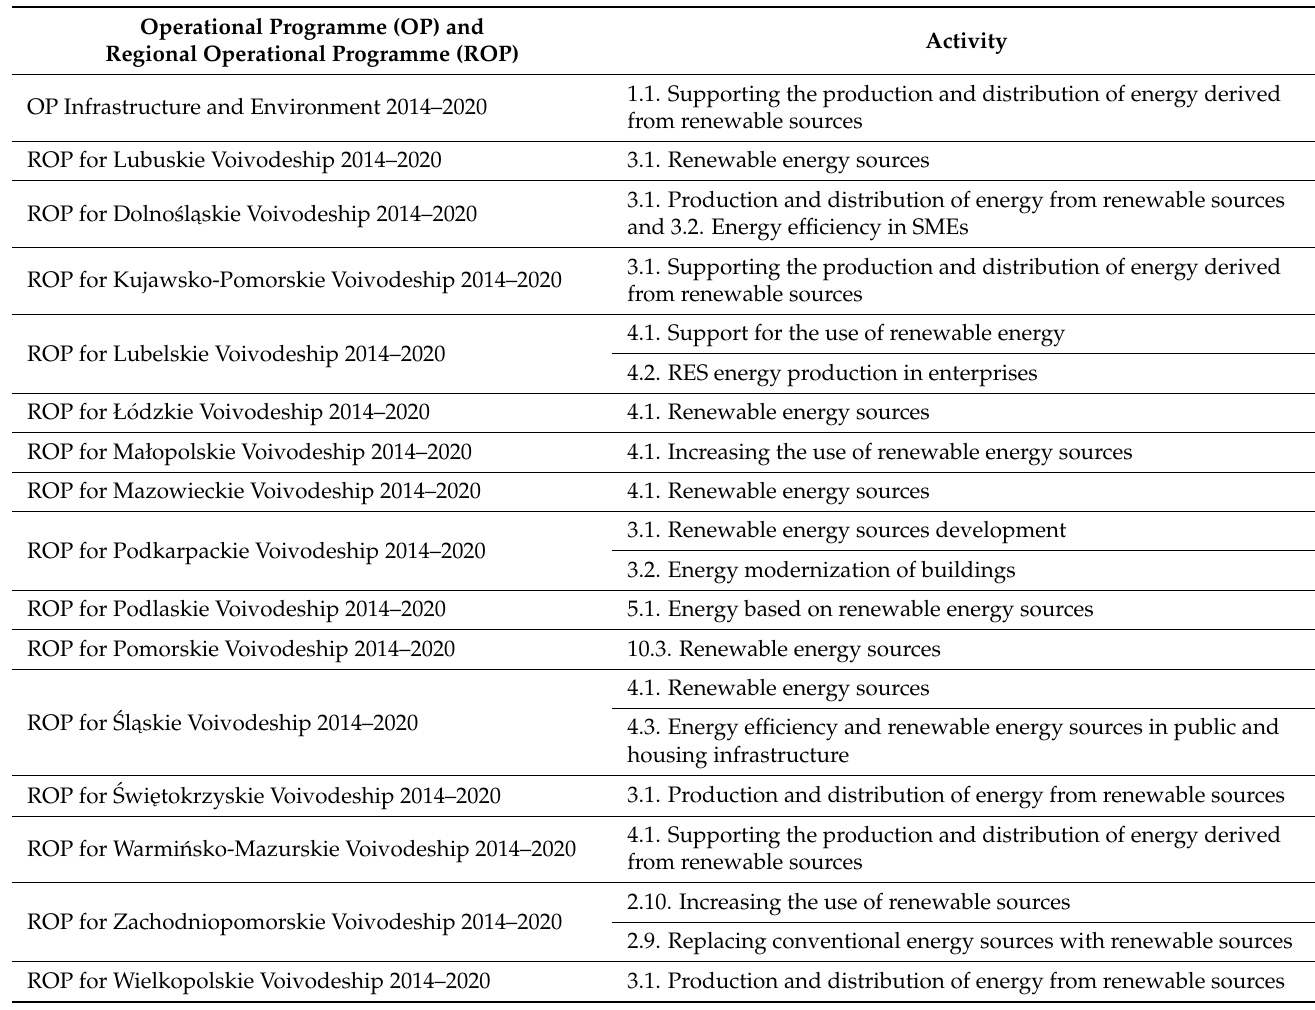
Table 5. Strategic approach of particular measures dedicated to renewable energy installations in Poland in the years